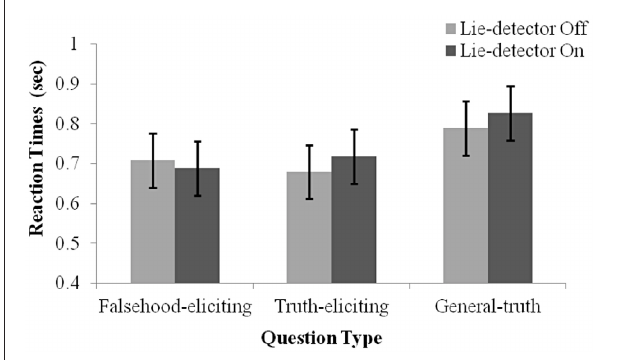
FIGURE 2 | Mean RT under the different conditions. Separate means are given for false, true and general responses with the lie-detector “on” and “off”. Error bars represent one standard error of the mean. Participants’ responses were slower for general questions than for theft-related questions. RTs to truth- and falsehood-eliciting theft-related questions did not differ, and RTs were not modulated by whether the lie-detector was “on” or